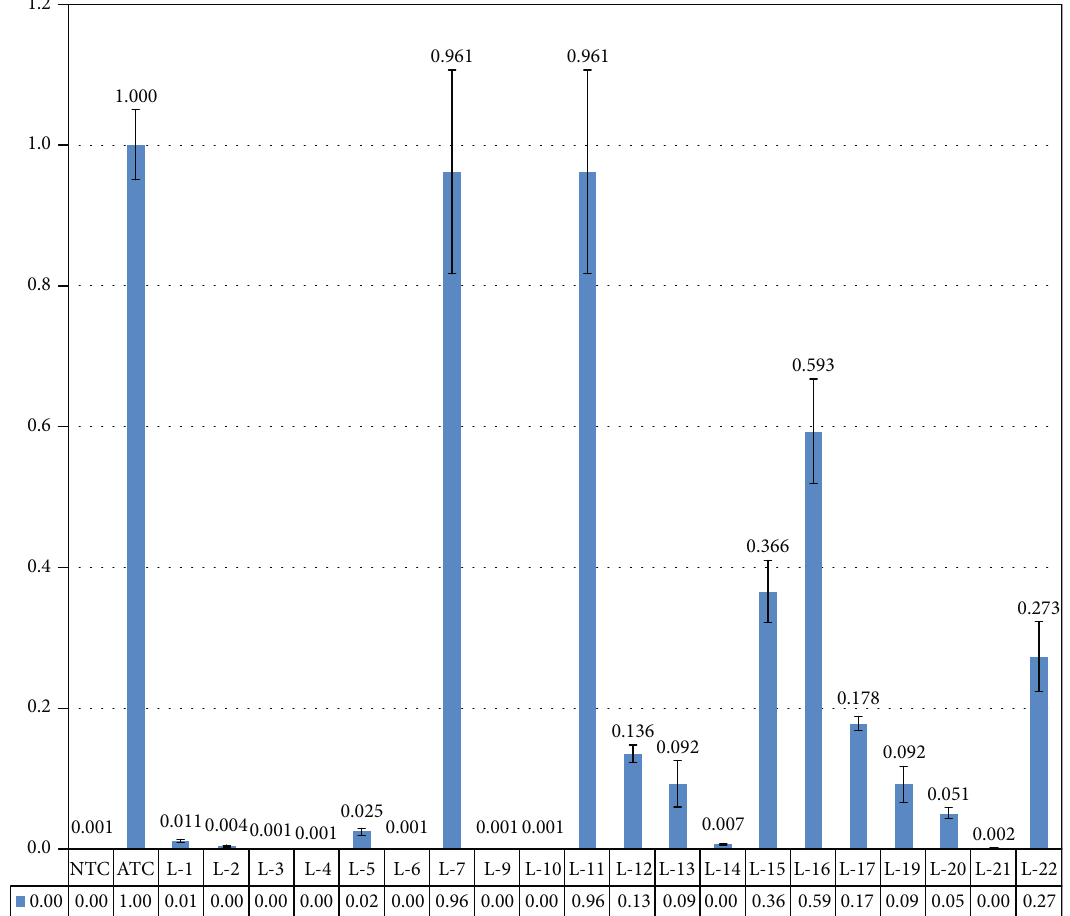
Figure 9: qRT-PCR analysis of imatinib-resistant patient ’ s response against the 2nd-generation. L2, L3, L4, L6, L9, L10, L14, and L21 showed complete molecular response. However, CML patients L1, L5, L13, L19, and L20 showed major molecular response (MMR) BCRABL transcript less than 0.1%. But CML patients L7, L11, L12, L13, L15, L16, L17, and L22 showed no response. Table 7: Previously reported fi ve-way Ph complex variant translocations in